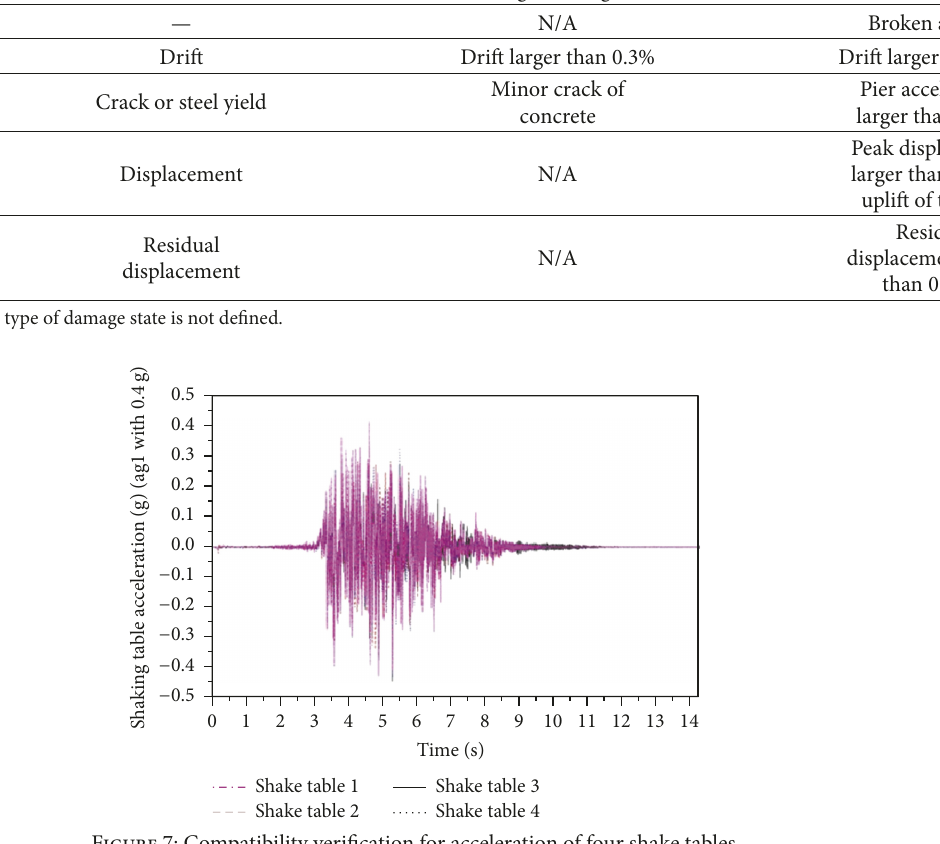
Figure 7: Compatibility verification for acceleration of four shake